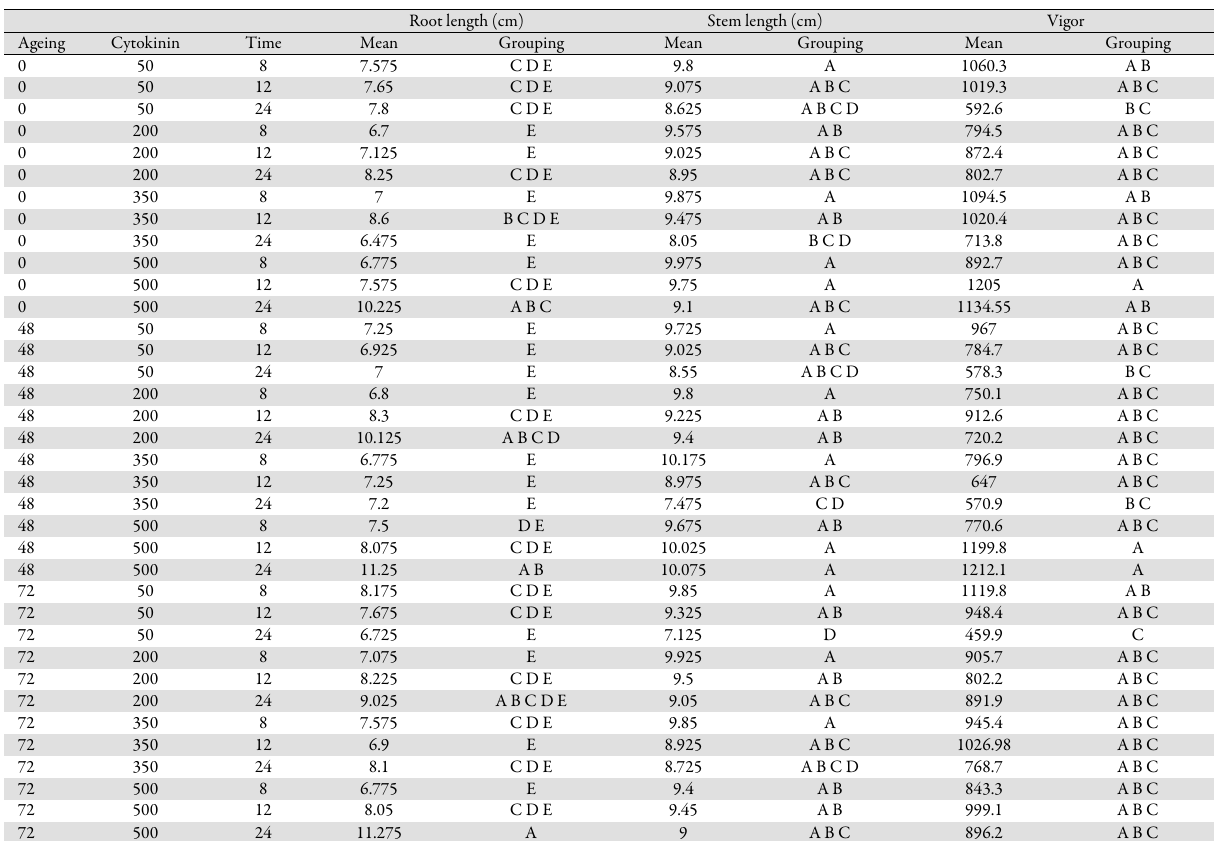
Table 6. Mean comparison of interaction of ageing, priming duration and cytokinin concentrations on root length (cm), stem length (cm) and seed vigor of Silybum